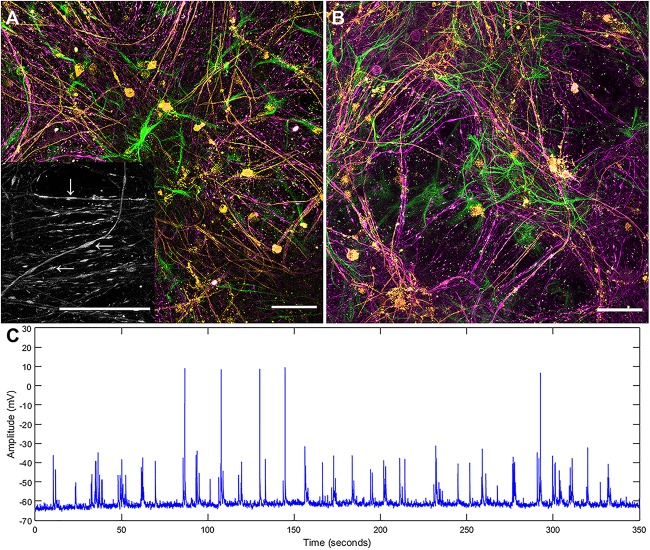
Maximum intensity projections of successful continuous co-culture grown of (A) glass and (B) platinum surfaces. Co-cultures were grown for 21 days, displaying myelinated neural networks with an abundance of astrocytes. Inset in (A) is a 2x enlargement of the underlying H-NF channel only. Although the axons show accumulations of H-NF (swellings along the axons indicated by arrows in inset) which suggests neurodegeneration is occurring (Dale and Garcia, 2012). (C) Representative patch clamp recording of spontaneous activity in a control culture. Green – GFAP, Orange – PLP/DM20 and Magenta – H-NF (Scale bar = 50 μm).